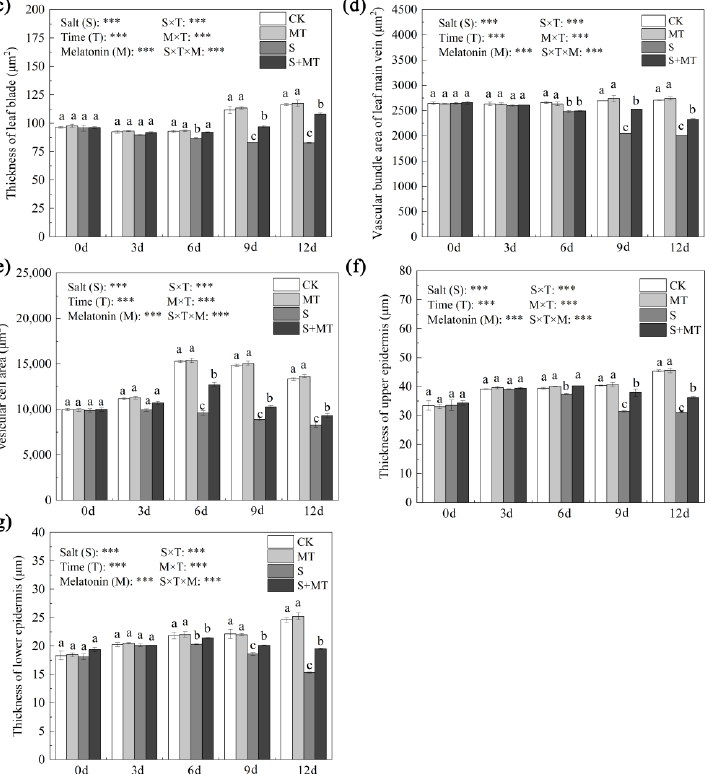
Figure 3. Exogenous application effect of melatonin on the leaf tissue of C. leucochlora seedlings under salt stress. ( a ) Middle transverse section of the leaf anatomy; ( b ) partial cross-section of the leaf; bar charts showing ( c ) thickness of the leaf blade; ( d ) vascular bundle area of the leaf main vein; ( e ) bulliform cell area; ( f ) thickness of the upper epidermis; ( g ) thickness of the lower epidermis. ue = upper epidermal cell; le = lower epidermal cell; vc = vesicular cell; sm = spongy mesophyll. The error bars represent the standard deviation. Significance levels are presented for each main effect or interaction. *** p < 0.001.